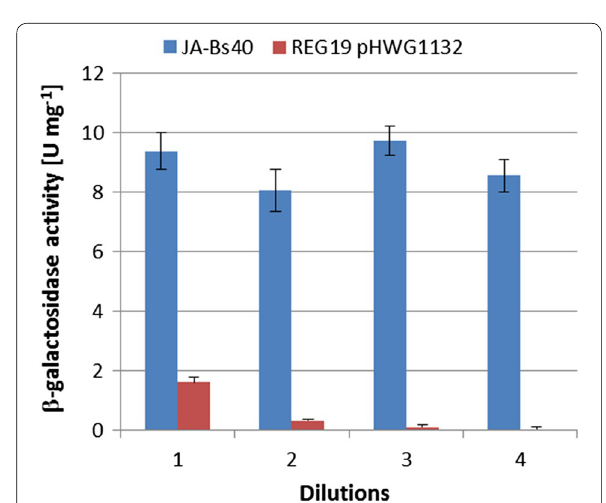
Fig. 5 GanA ß-galactosidase activities in crude extracts of cells from JA-Bs40 and REG19 pHWG1132 diluted 1000-fold and grown to stationary phase repeatedly without antibiotics in LB with 0.5% glucitol. The values are the mean of three different